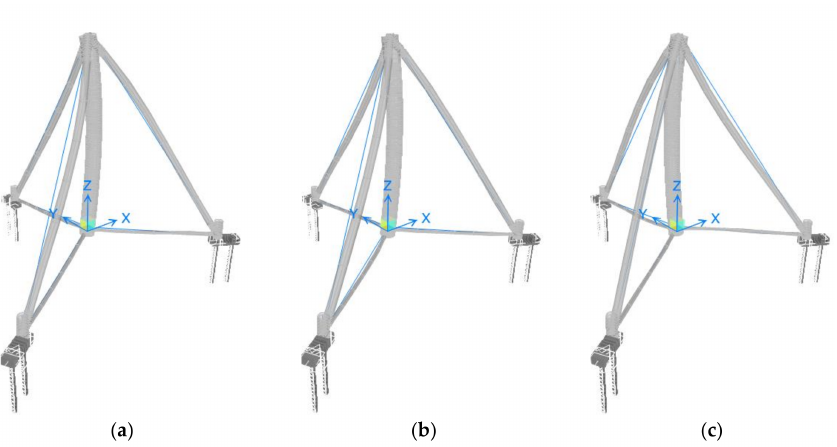
Figure 14. Deformed shapes (exaggerated deformation scale): ( a ) loading scenario 1, ( b ) loading scenario 2, and ( c ) loading scenario 3.